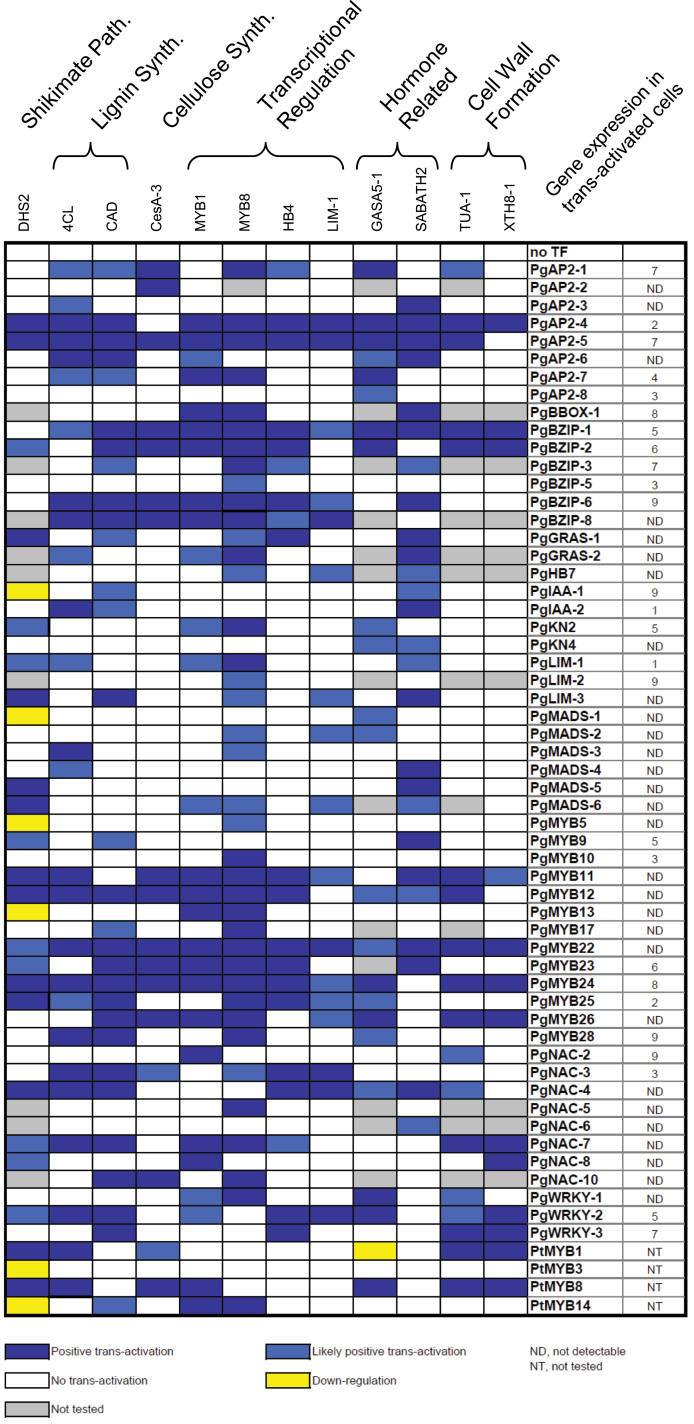
Transient trans-activation assays leading to the identification of specific interactions. Each box represents the observation of the histochemical test compared with the control without TFs. The PgDHS2 and PgGASA5-1 promoters alone showed faint GUS staining and loss of expression (relative to the control) was observed with specific TFs (yellow). Relative gene expression levels for each TF based on PiceaGenExpress are indicated on the right. This database was developed from transcript profiles obtained for eight different tissue types coming from five independent experiments (Raherison et al., 2012). Briefly, the genes were ranked based on their signal intensities within a tissue type and equally divided into 10 separate classes according to their signal intensity: class 1: 10% lowest signal intensities; class 10: 10% highest signal intensities (see Raherison et al., 2012 for details). None of the genes tested were ranked in class 10.